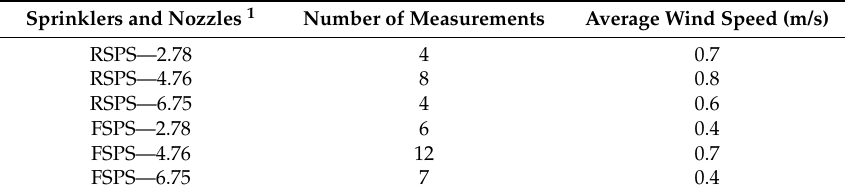
Table 4. Basic information regarding experimental